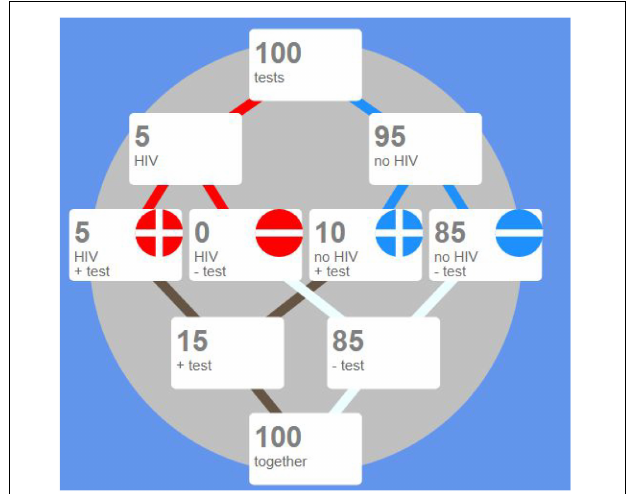
FIGURE 7 | A double tree for inference on the HIV